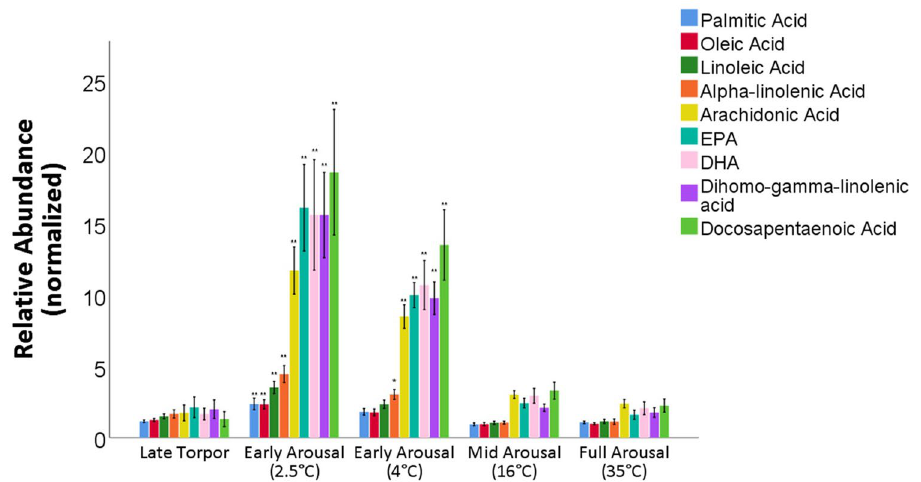
Figure 6. Plasma metabolomic analysis during natural arousal from torpor shows spike of PUFA metabolites during early arousal. Plasma Fatty Acids and PUFAs increase significantly during early natural arousal from torpor. Data shown are relative abundance normalized to plasma sample collected at entrance into torpor at a T b of 11–12 °C. The x-axis are phases of rewarming in natural arousal from torpor. (*p < 0.05, **p < 0.001 vs late torpor, post hoc Tukey, n = 9). Measurements are from individual animals sampled over a single, undisturbed natural arousal fed Standard Rodent Chow. Blood was sampled at specific core body temperatures (T b ) during arousal ranging from early arousal (2.5 °C) to full arousal (35 °C). Data shown as mean ±